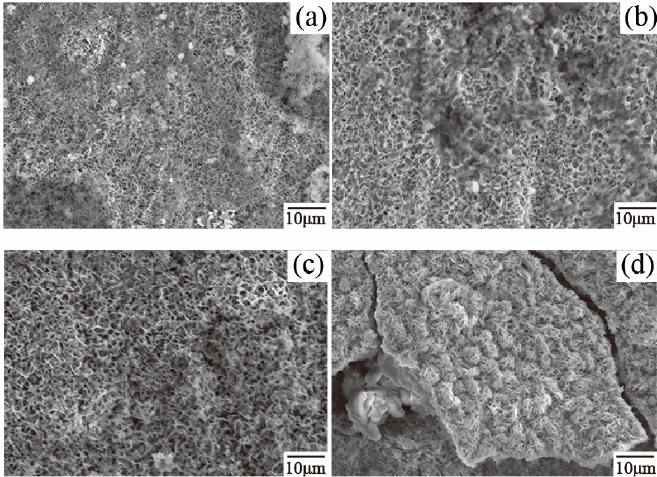
Figure 11. The microstructure of corrosion products: ( a ) 23AZS, ( b ) 23AZS–1.5Mg, ( c ) 23AZS–3Mg, and ( d ) 55AZS specimens.